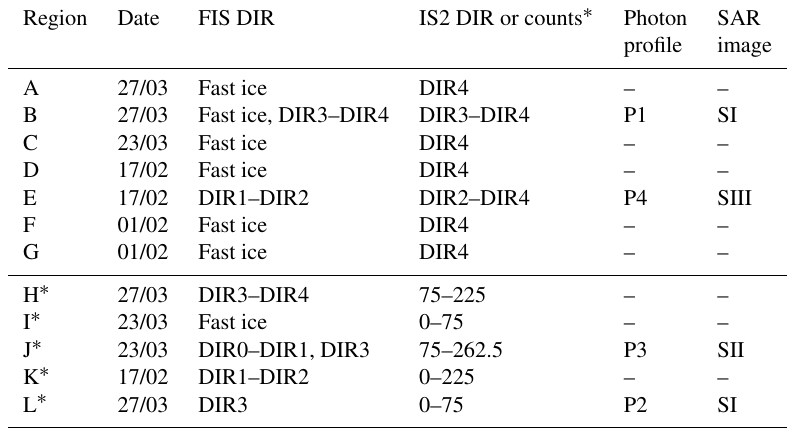
Table 3. Overview of the investigation of cases. ∗ Cases based on proxy for ridge densities, in Fig. 5. Region FIS